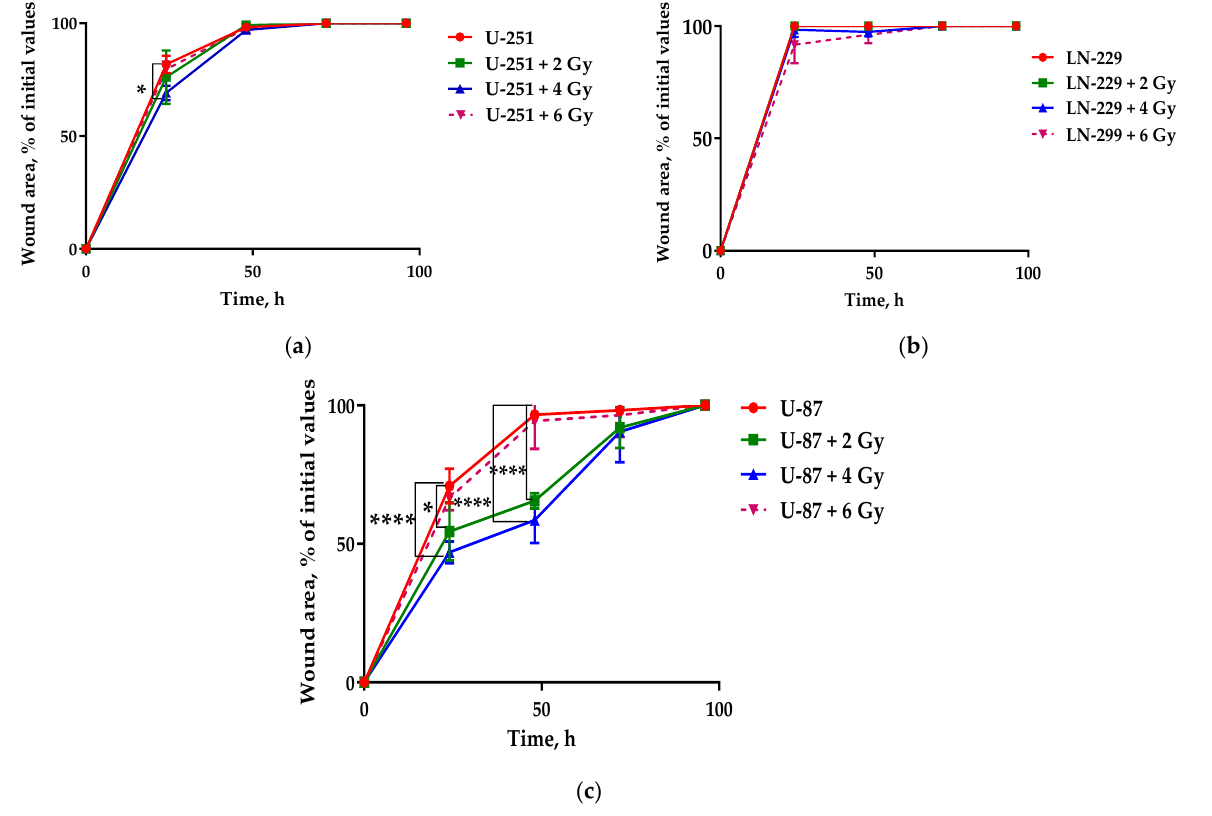
Figure 2. The migration ability of control and treated GBM cells. ( a ) Time-lapse images of a represen- tative scratch assay (wound healing). In each image, the wound area was detected by applying the segmentation algorithm and is plotted in blue. The percentage of the migration ability of ( a ) U-251, ( b ) LN-229, and ( c ) U-87 cells 24 h, 48 h, 72 h, and 96 h after mechanical scratching. Data are means ± SEM of three independent experiments. * p ≤ 0.05, **** p ≤